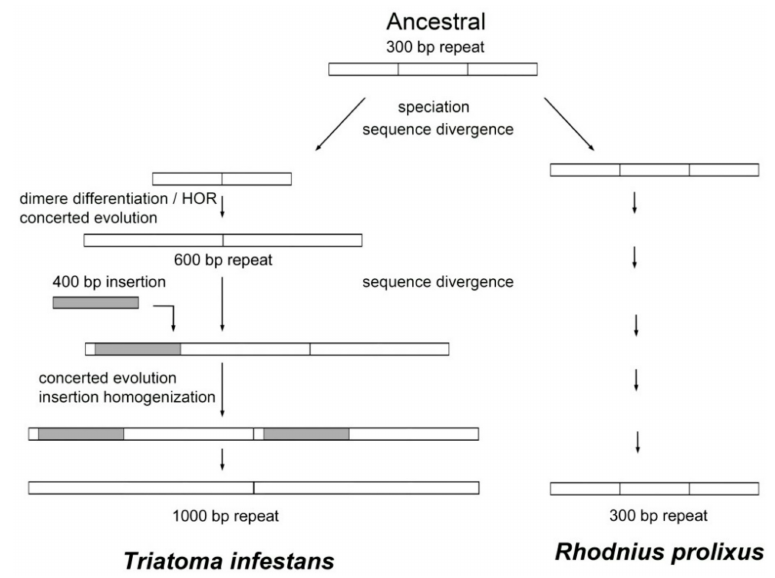
Figure 4. Hypothetical pathway of the TinfSat04-1000 satellite DNA in T. infestans and R. prolixus . The ancestral situation would be the existence of a satDNA family with a repeat unit of 300 bp. This organization could be retained in the R. prolixus genome. The evolution of this repetitive DNA would be more complex in T. infestans. The 300 bp ancestral satDNA could have generated a new satDNA family with a repeat unit of 1000 bp. First, a HOR would have formed from a dimer, which would generate a 600 bp satDNA. Second, an insertion of about 400 bp would have taken place within this new repetition. Concerted evolution would spread this insertion resulting in a new tandem repeat of 1000 bp.